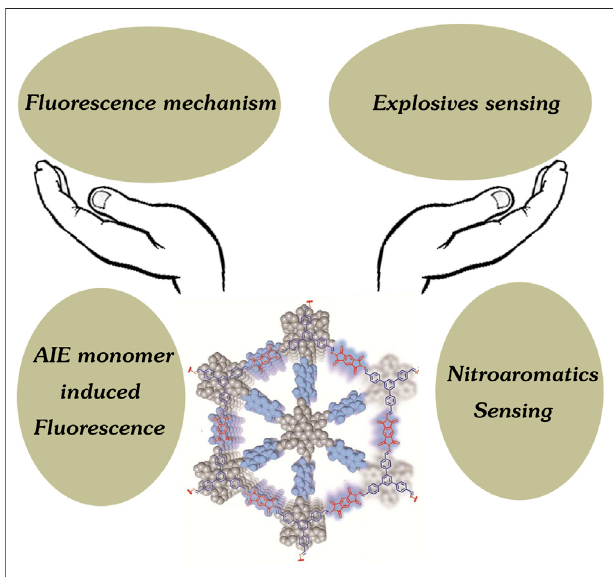
FIGURE 1 | Schematic presentation of COF fl uorescence mechanism and explosive sensing.